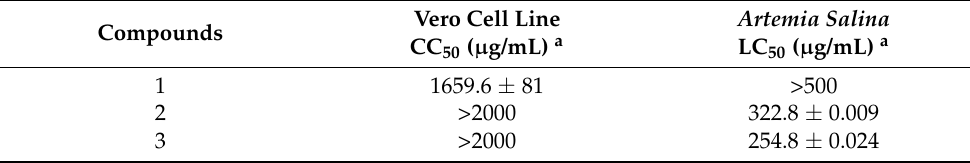
Table 2. In vitro toxicity data of compounds 1 , 2 , and 3 on Vero cell line and Artemia salina assay. Vero Cell Compounds